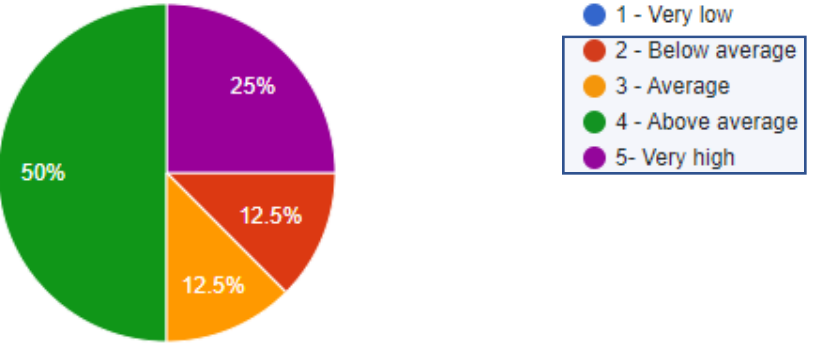
Figure 9. Students’ analysing skills after 2nd smart classroom activity (Subject 2).